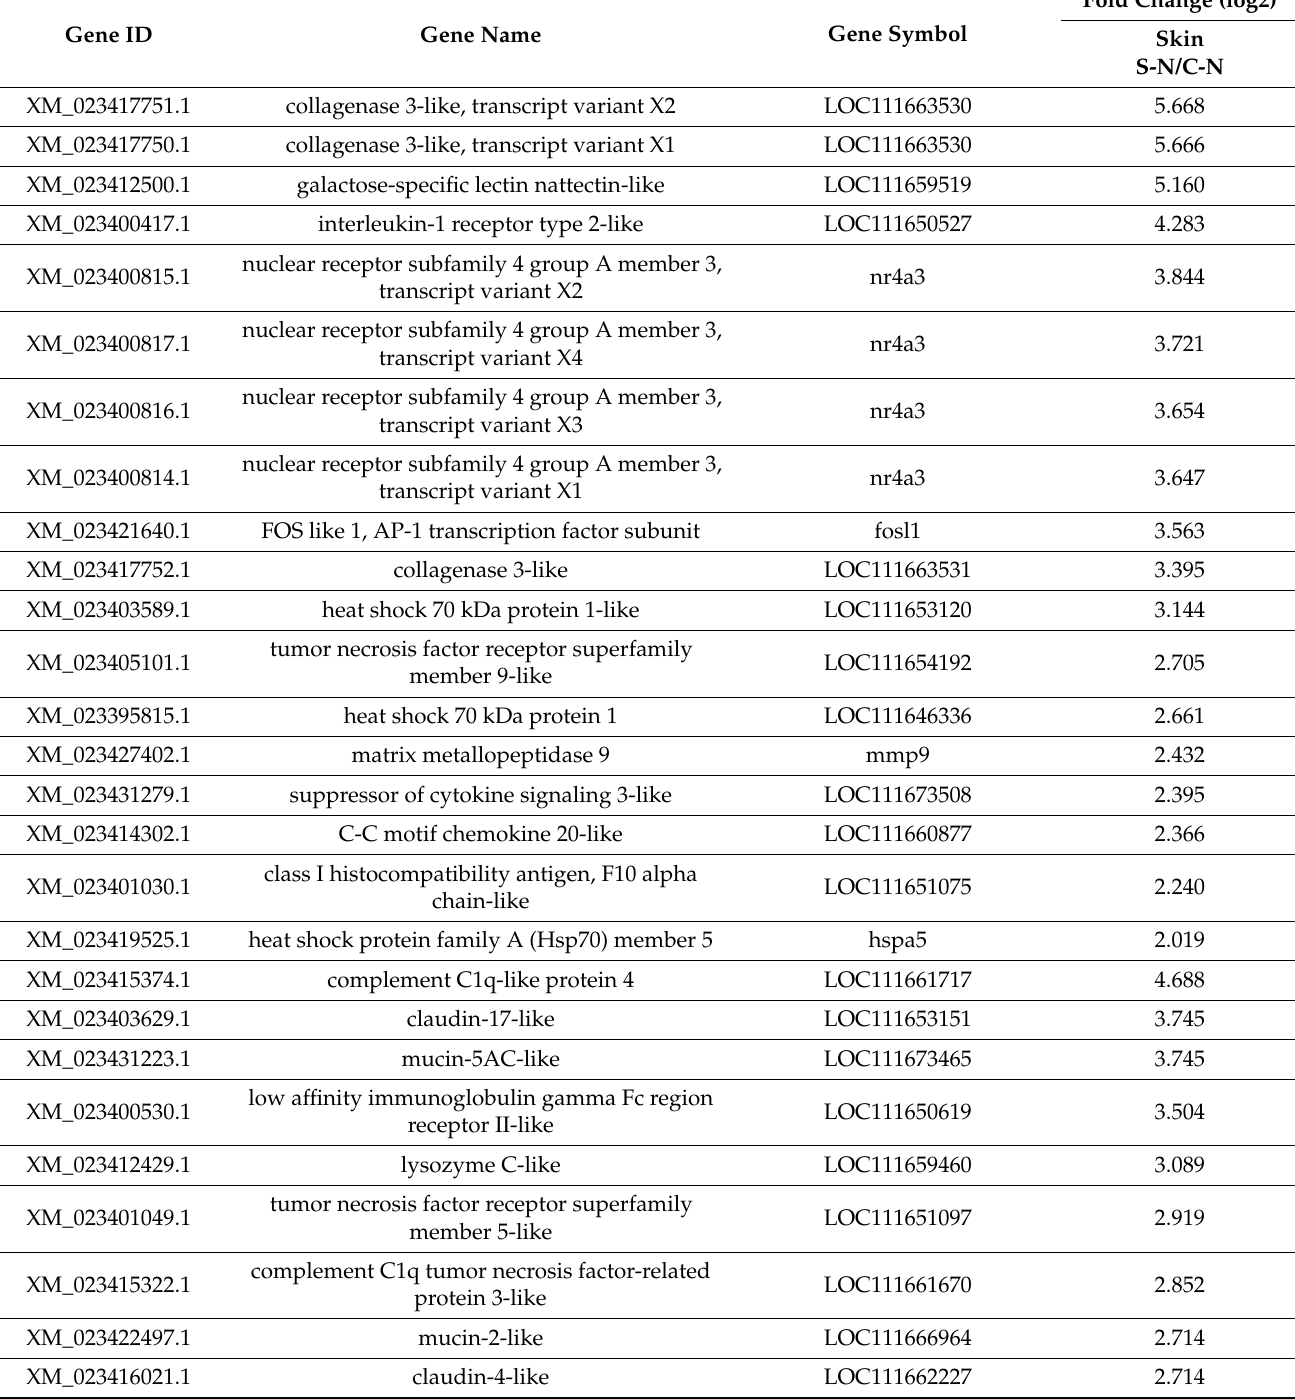
Table 1. List of upregulated immune-related genes (log2 fold-change > 2) and their expression ratio in skin of yellowtail after being fed silkrose-containing